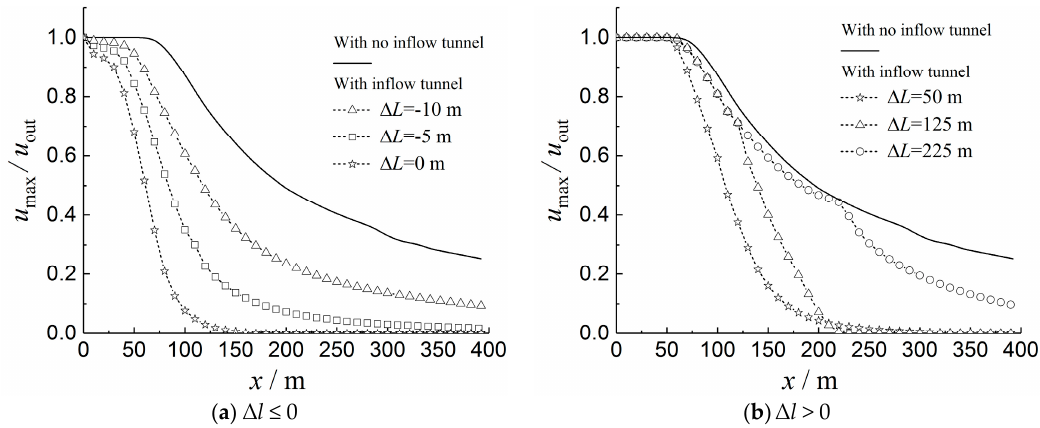
Figure 8. The decay of nondimensional maximum velocity u max in the symmetry plane.